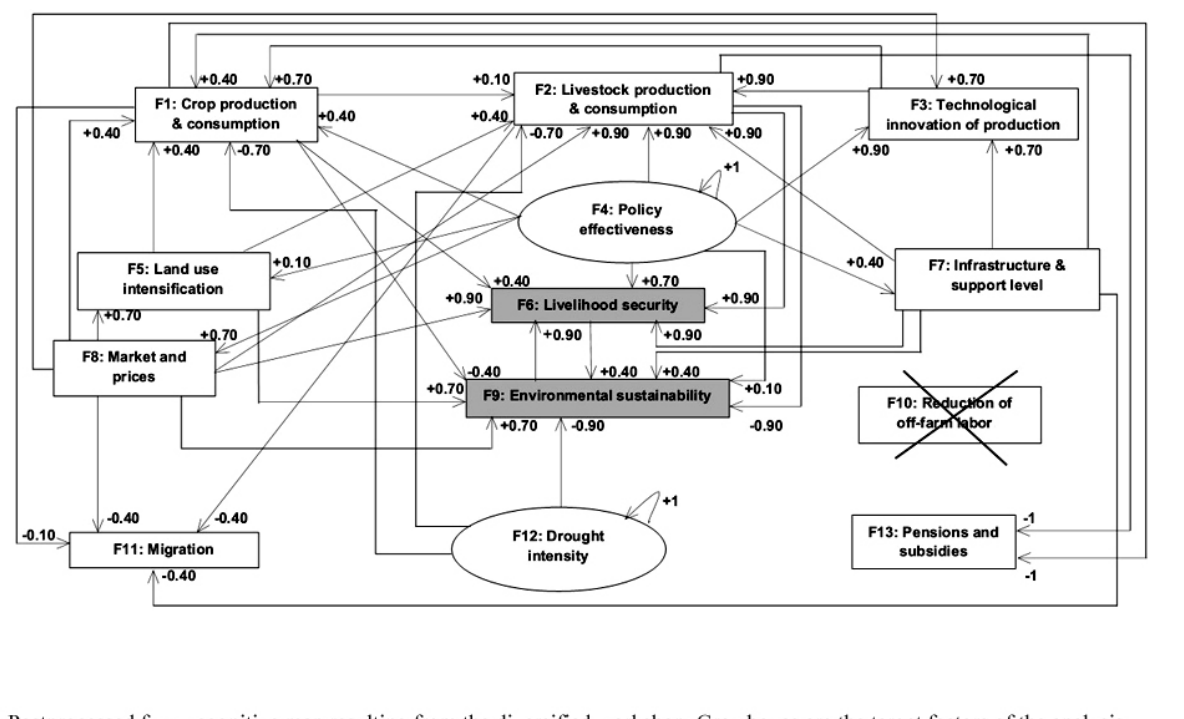
Fig. 4 . Postprocessed fuzzy cognitive map resulting from the livestock workshop. Grey boxes are the target factors of the analysis, white boxes are the general factors, and white circles are the drivers of the system. Numbers given are the weights between factors, indicating positive and negative relationships. The crossed out box indicates the factor excluded by the